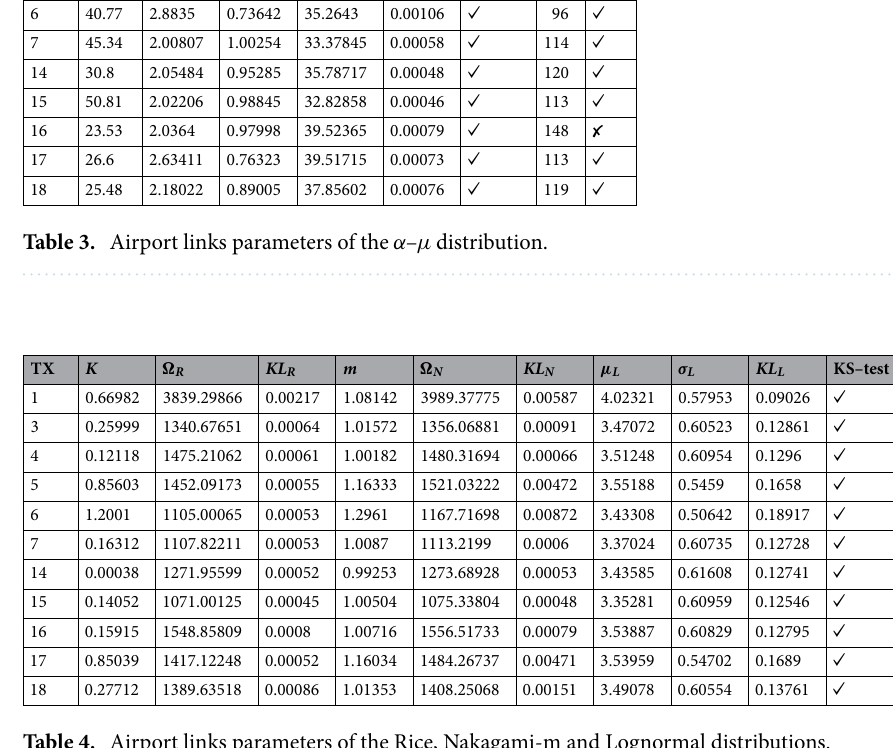
Table 4. Airport links parameters of the Rice, Nakagami-m and Lognormal